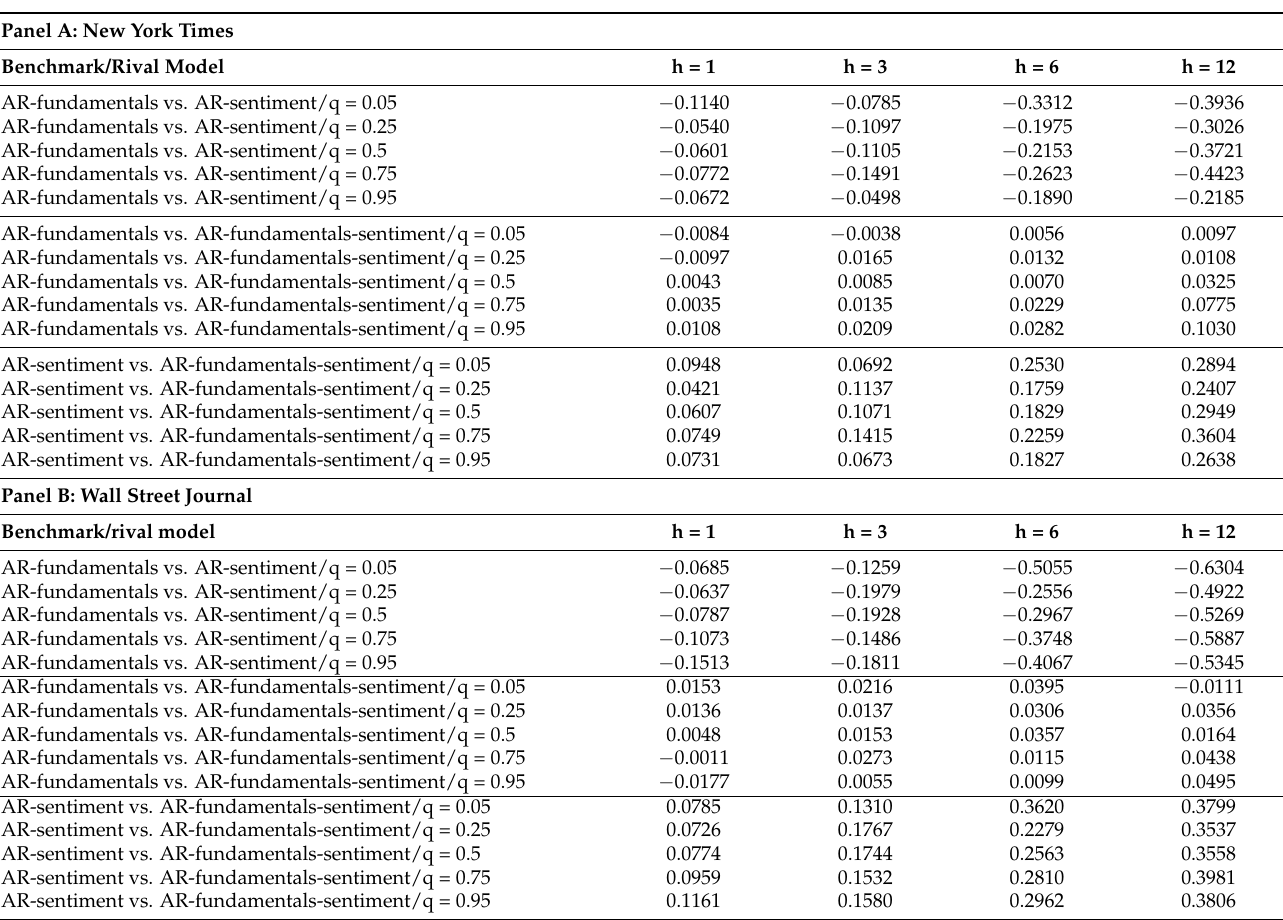
Table A3. Results for good realized